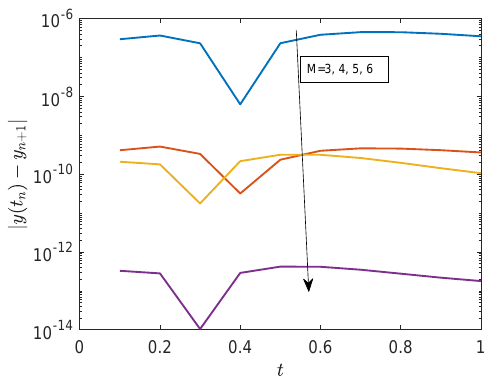
Figure 3. Errors for example 2.